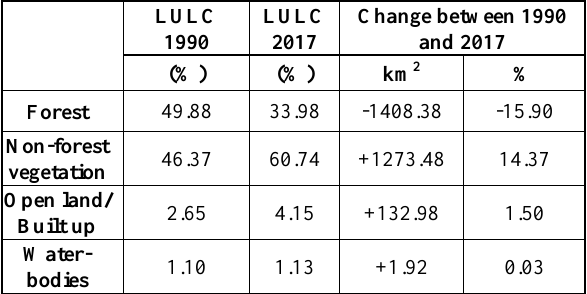
Table 1. Different land use concentration between 1990 to 2017